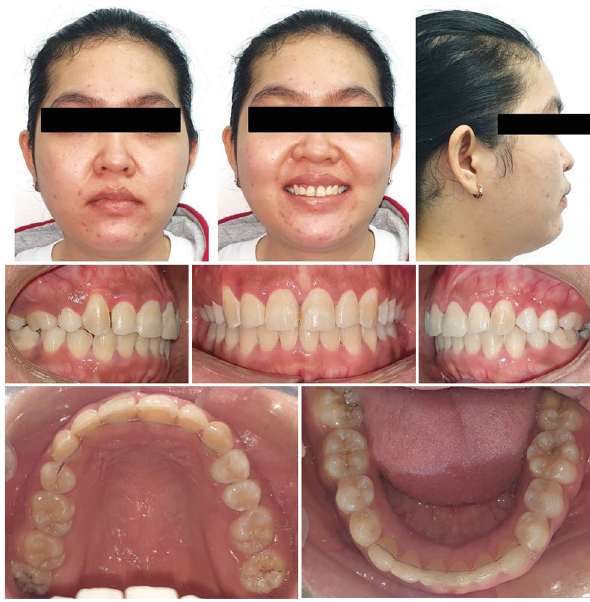
Figure 10: Treatment records at one-year follow-up